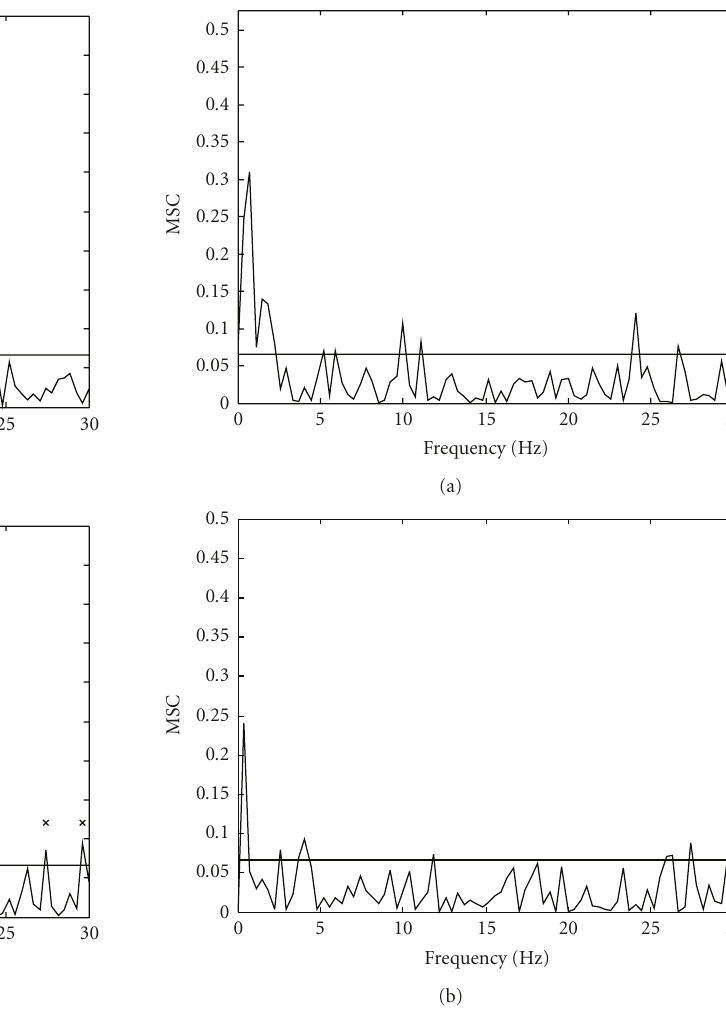
Figure 7: MSC ( M = 45) for subject #10’s at Cz channel. (a) During left index finger movement. (b) During left index finger movement imagination. The critical value (MSC critic = 0 . 0658) is represented by the horizontal line. For frequencies higher than 30Hz there was no response